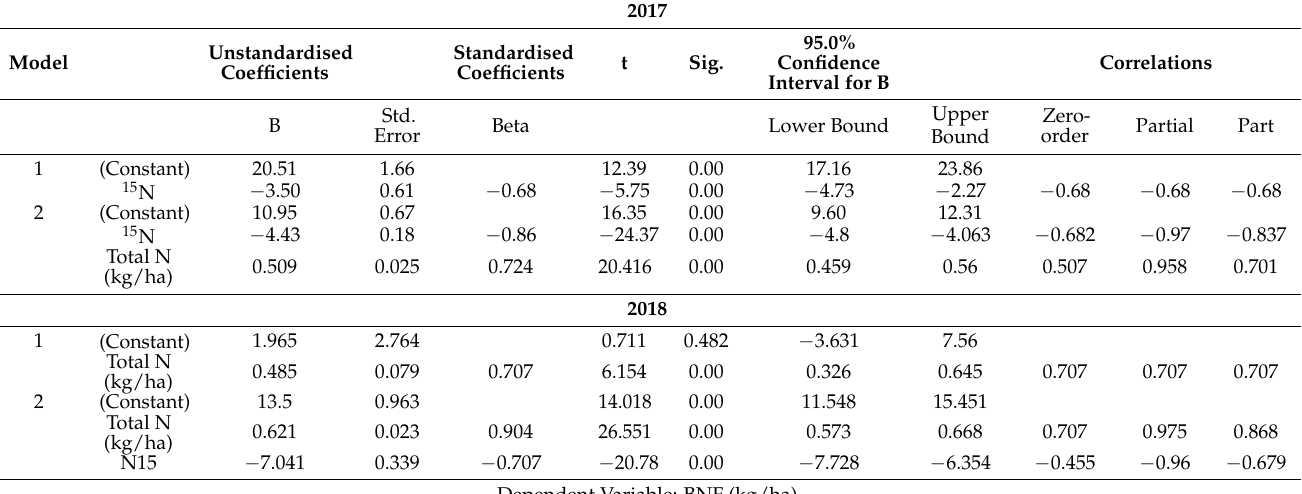
Table 8. Multiple linear regression on the factors that influence biological nitrogen